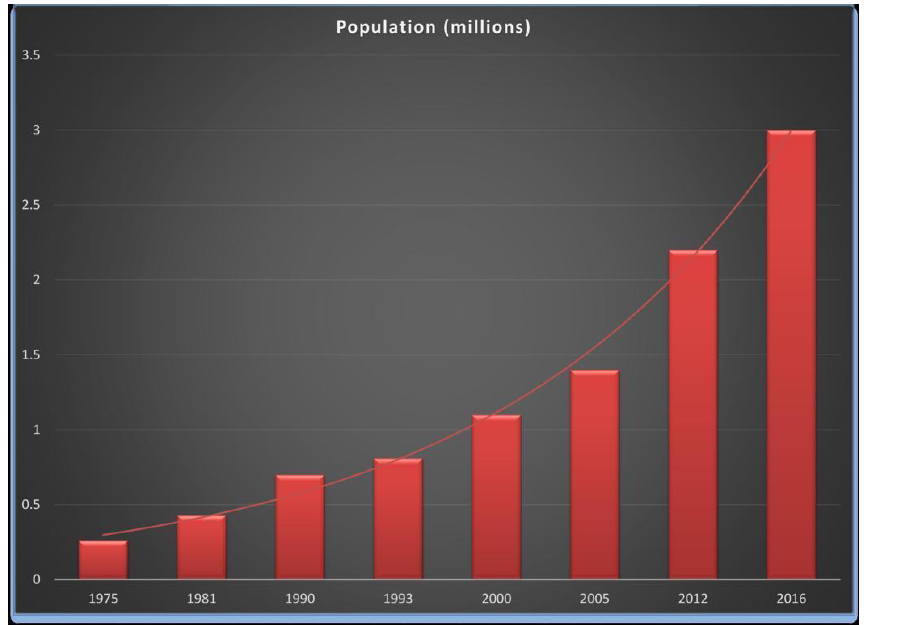
Figure 8. Graph of population in Quetta valley which increased from 0.26 million in 1975 to 3.0 million in 2016.